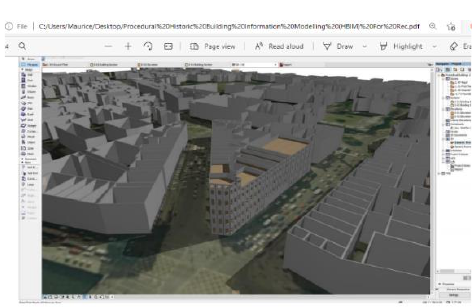
Figure 13. Rule 5 - Replacement Rule.